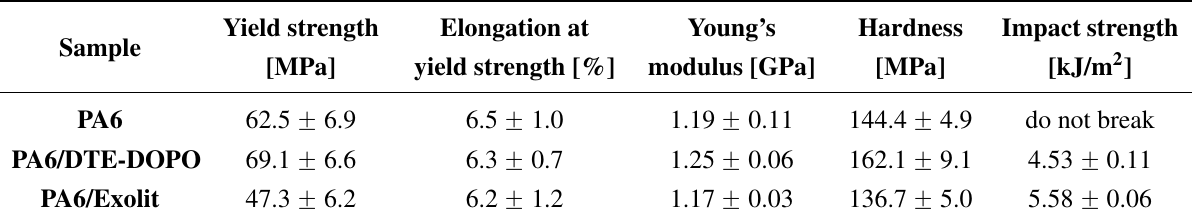
Table 2. Mechanical properties of PA6